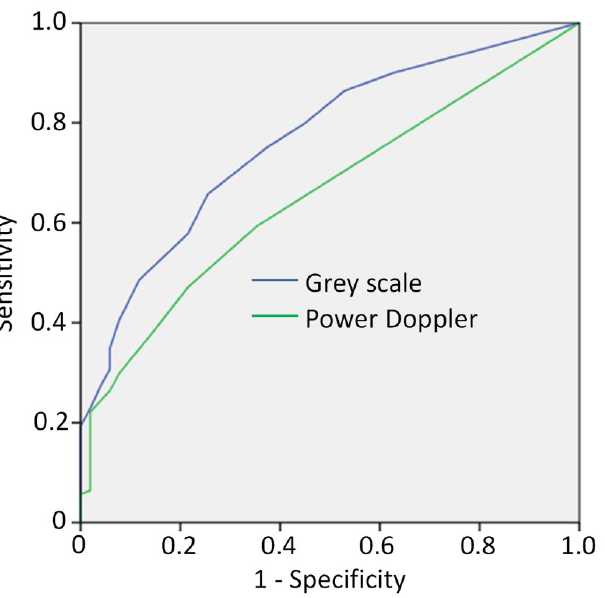
Figure 1. Receiver operating characteristic (ROC) curve to evaluate whether US scores could discrim- inate PsA from FMS using grey scale (dark blue line) and Power Doppler mode (green